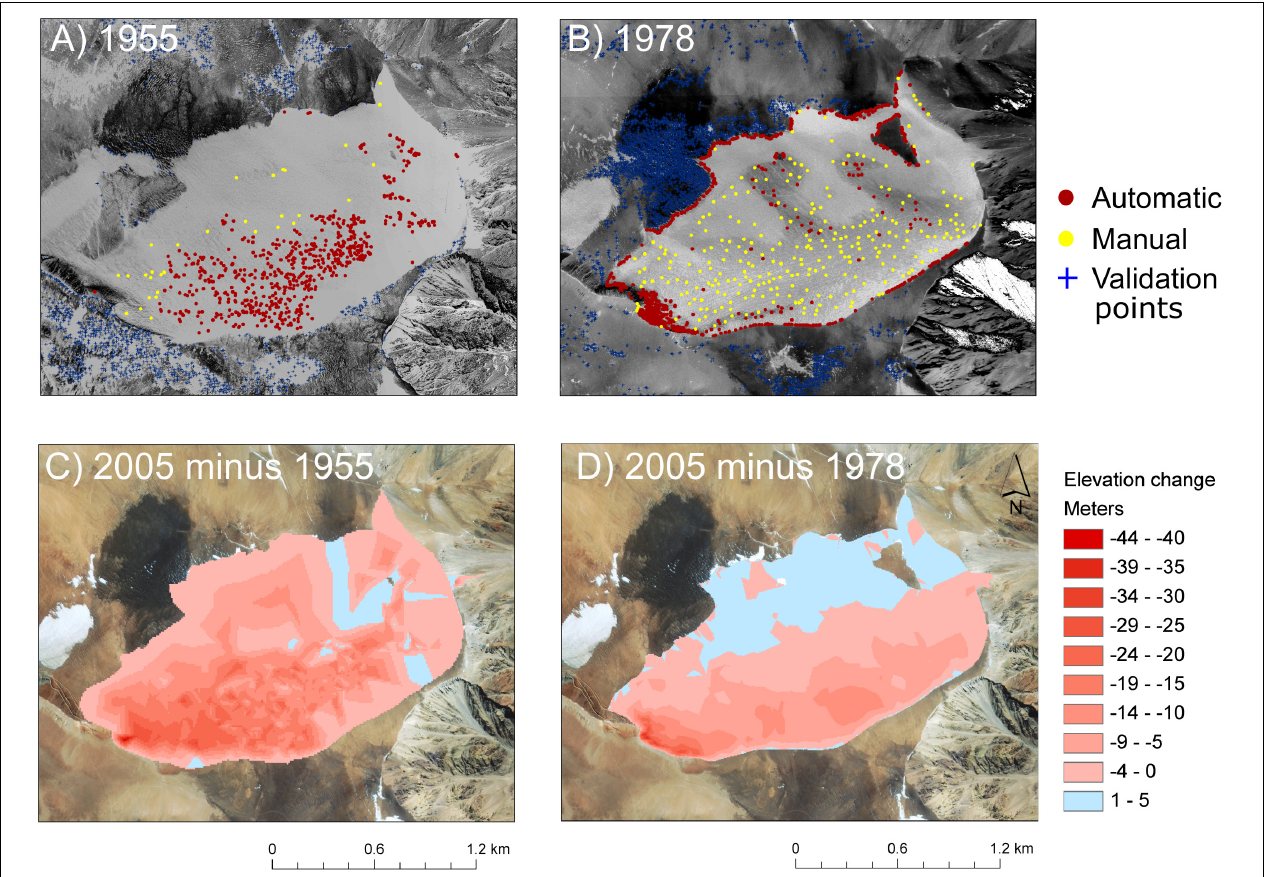
FIGURE 5 | Historical elevation changes on Guanaco Glacier for 1955-2005. (A) 1955 air photo showing elevation values extracted automatically (red dots) and manually (yellow dots), as well as validation points outside the glacier (blue crosses). (B) Same as (A) but for the 1978 aerial photo. (C) Elevation changes between 1955 and 2005. (D) Elevation changes between 1978 and